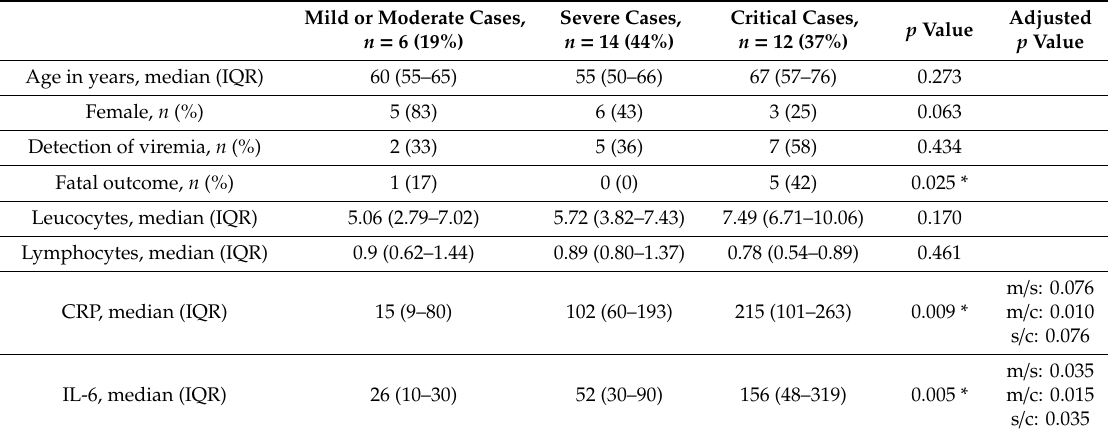
Table 1. Patient characteristics according to disease severity of coronavirus disease 2019 (COVID-19) and laboratory parameters at time of first positive respiratory RT-PCR after hospital admission. Mild or Moderate Cases, n = 6